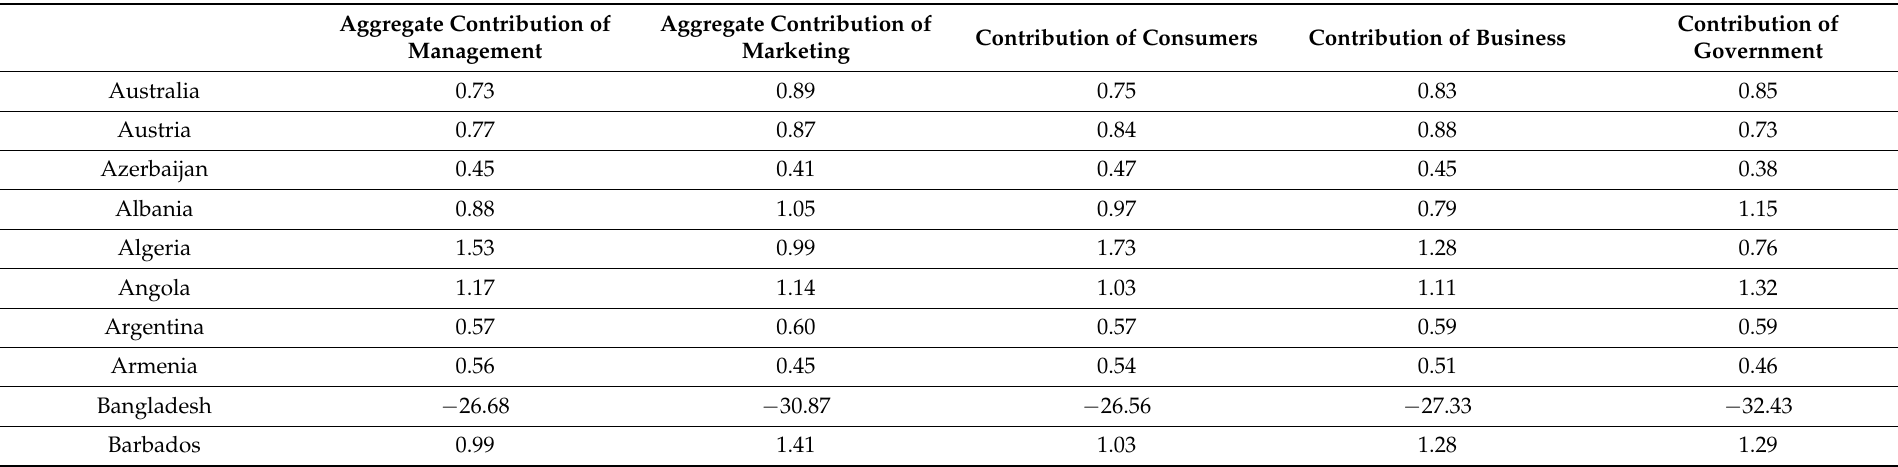
Table A5. Contribution of a set of management and marketing factors to the pandemic risk management in the second trimester of 2020.